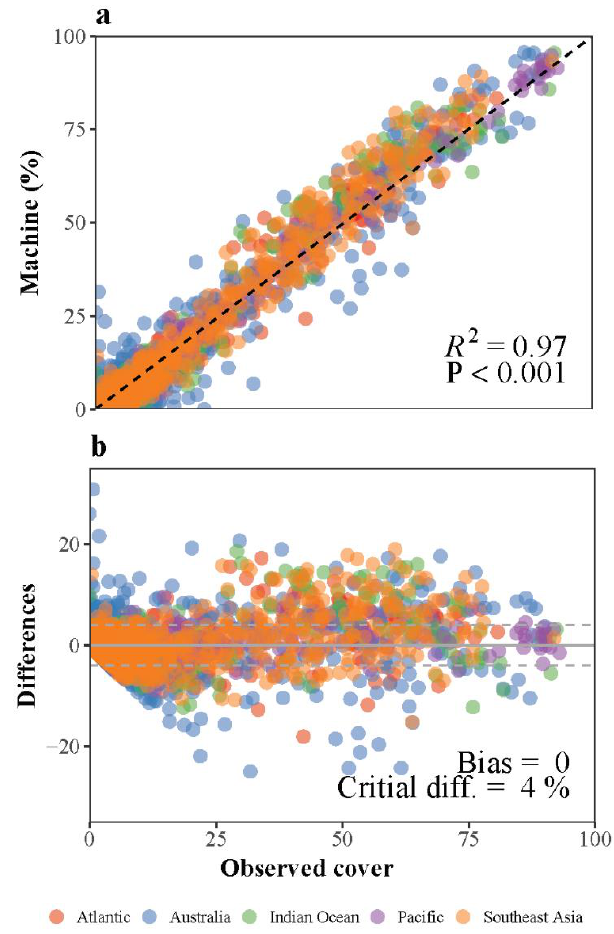
Figure A1. Overall agreement between network (machine) and manual (observer) estimation of abundance (cover). Agreement is here discretised in two metrics: ( a ) Correlation between machine and observer annotations and ( b ) bias. Each filled circle in these panels represents the estimated cover for a single by the machine and the observer in a given transect. The correlation shows that estimations of benthic abundance by expert observations are significantly represented by the automated estimations (R 2 = 0.97). The Bland-Altman plot shows that overall the differences (Bias) between machine and observer tend to mean of zero (grey continuous line), and a homogenous error around the mean, defined by Critical Difference (Critical Diff.) or the 95% confidence interval of the difference between observers and machines (dashed grey lines).